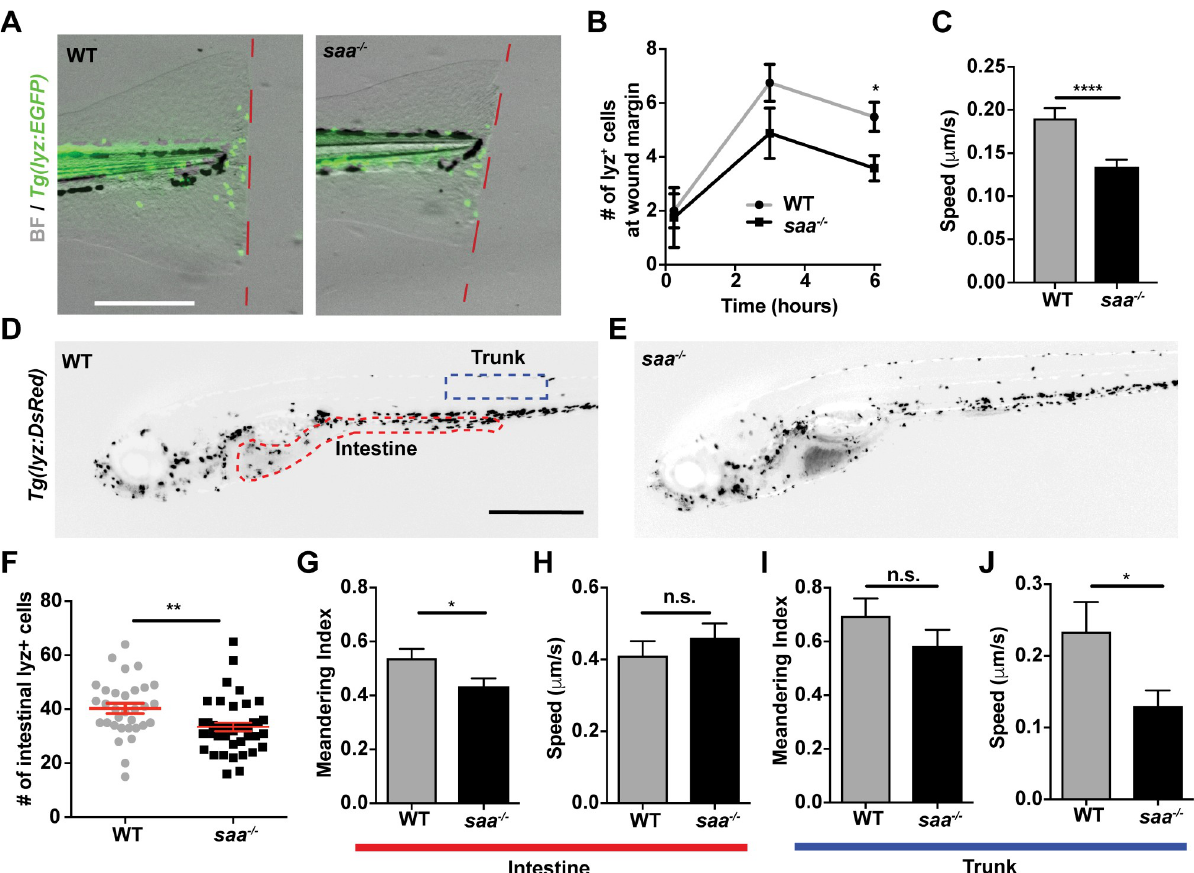
Fig 1. Saa mediates neutrophil behavior in vivo . (A-B) Imaging and quantification of lyz:EGFP + neutrophils recruited to tail wound margin over 6 hours following caudal fin amputation (dashed red line indicates wound margin; scale bar = 250 μ m) (n � 24 larvae / genotype at 6 hour time point). (C) Measurement of lyz:DsRed + neutrophil speed from time-lapse imaging in caudal fin tissue over 6 hour period following amputation (n = 4 larvae / genotype, 87–112 cells tracked / genotype). (D-E) Representative images of 6 dpf Tg(lyz : DsRed) WT and saa -/- larvae (scale bar = 500 μ m). (F) Enumeration of intestine-associated lyz:EGFP + cells in 6 dpf larvae (n = 32–40 larvae / genotype). (G-J) Quantitative analysis of lyz:EGFP + neutrophil behavior from time-lapse imaging of distinct anatomical compartments (intestine and trunk, ROIs in panel D) in 6 dpf larval zebrafish (6 larvae / genotype, � 23 cells analyzed / genotype / tissue). Data analyzed by t -test. For panel B, statistical comparisons were performed within each time point. Data are presented as mean ± SEM. � p < 0.05, �� p < 0.01, ��� p < 0.001, ���� p < 0.0001.